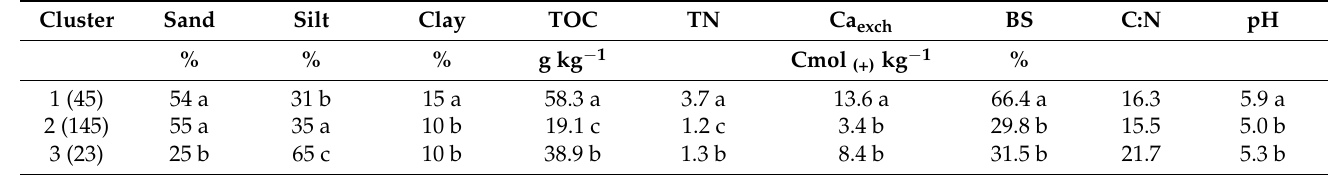
Table 5. Mean of sand, silt, clay, total organic carbon (TOC), total nitrogen (TN), and exchangeable Ca (Ca exch ) contents, and BS, TOC–to–TN ratio (C:N), and pH values of the clusters obtained via cluster analysis on the set of data below 1000 m above sea level. Within each column, values sharing similar letters do not indicate significant differences (Kruskal–Wallis test, p < 0.05).